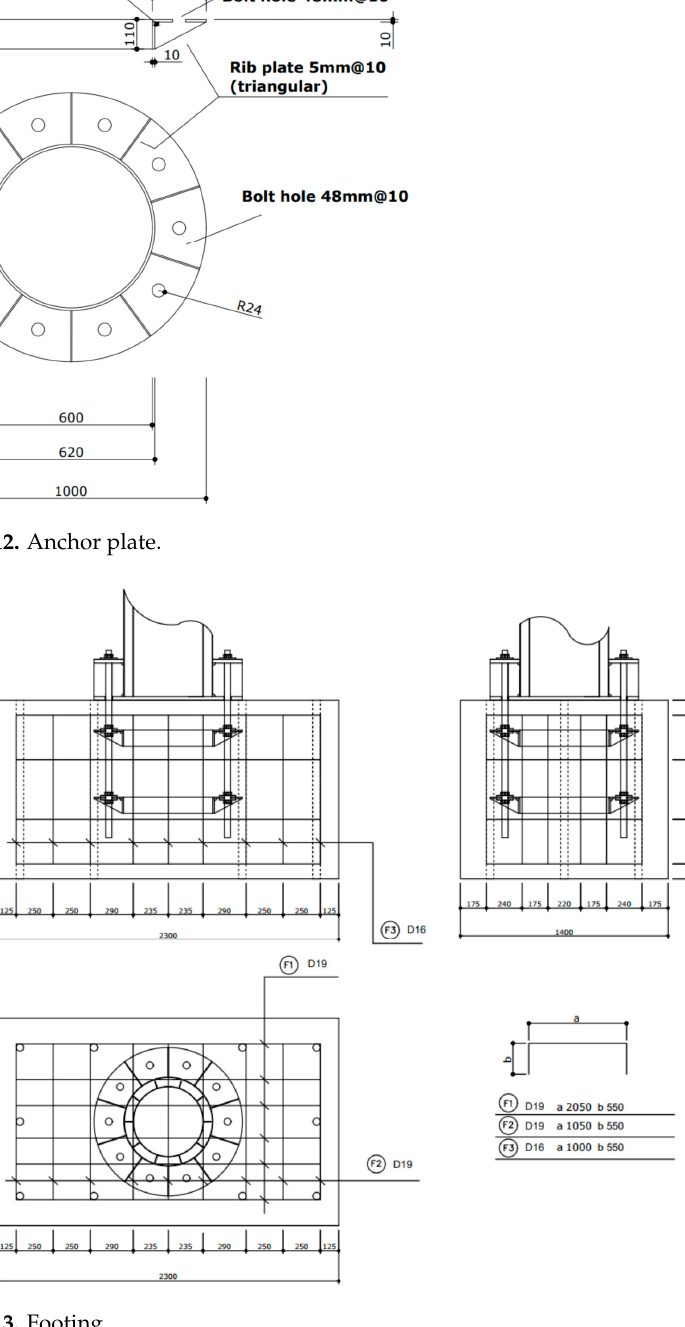
Figure 13. Footing. Figure 13.